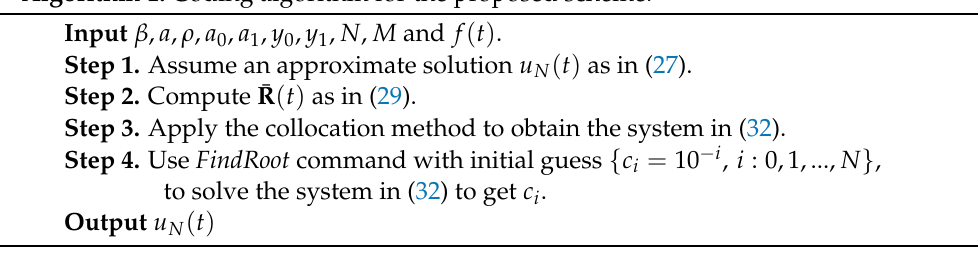
Algorithm 1: Coding algorithm for the proposed